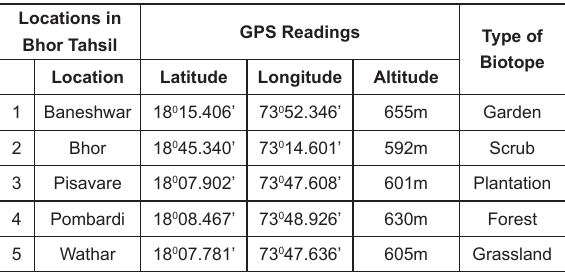
Table 1. GPS readings and biotopes of a few sites in Bhor Tahsil